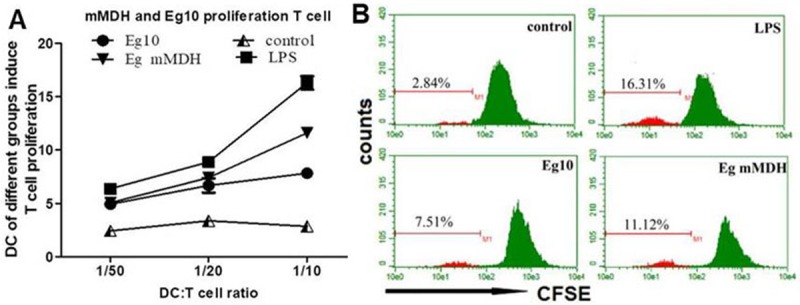
Proliferative abilities of T cells cocultured with antigen-exposed DCs.(A). DCs were activated with Echinococcus granulosus antigens and cocultured in graded amounts with allogeneic CD4+ T cells labeled with CFSE (DC/T cell ratio, 1:10, 1:20, 1:50). (B). Primary T cell proliferation was measured by determining the CFSE fluorescence intensity through flow cytometer. The data are means ± SD for triplicate cultures. Control means DCs are in RPMI1640 culture medium.